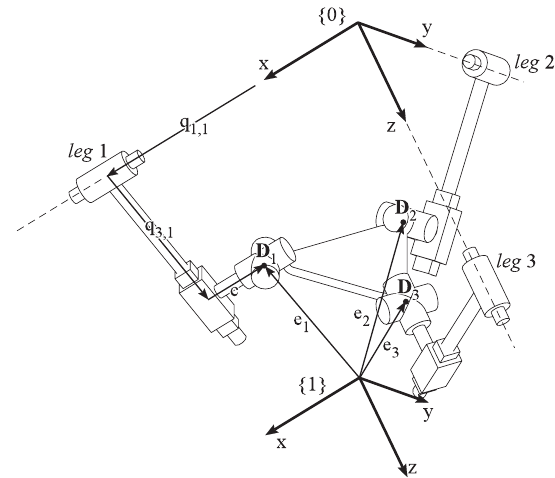
Figure 1. Kinematics of the 3-CPU pure translational parallel